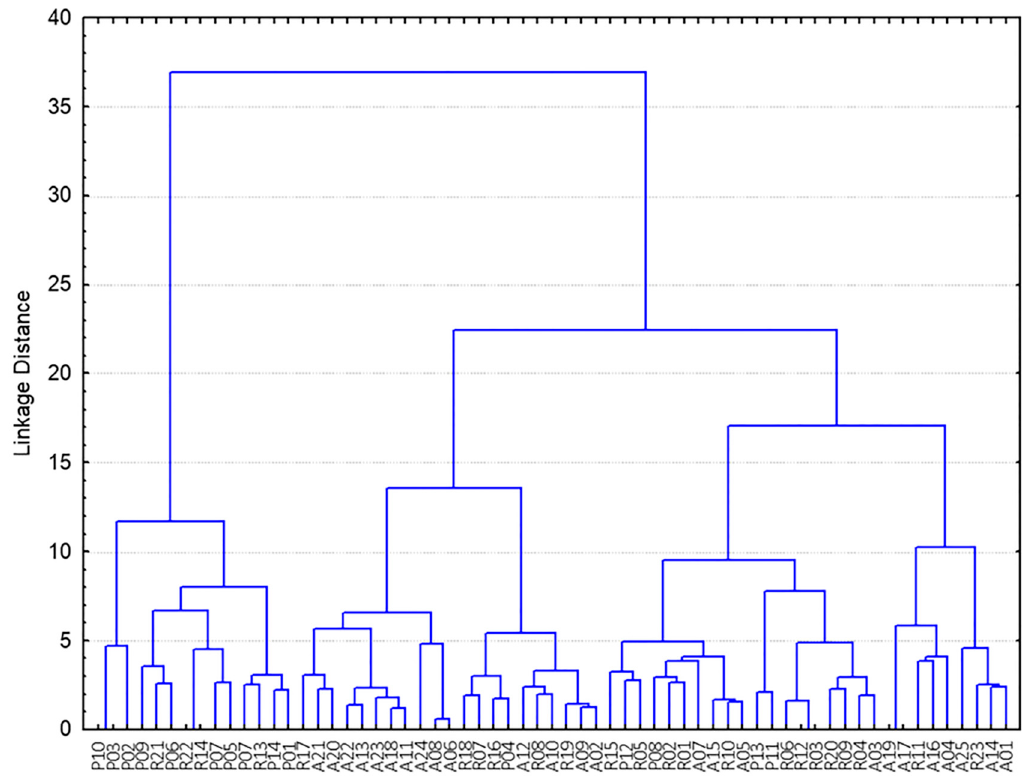
Figure 2. Hierarchical cluster analysis (HCA) dendrogram showing the distribution of samples from the three study groups. P: “Jamón de Cebo”, R: “Jamón de Cebo de Campo”, A: “Jamón de Bellota”.